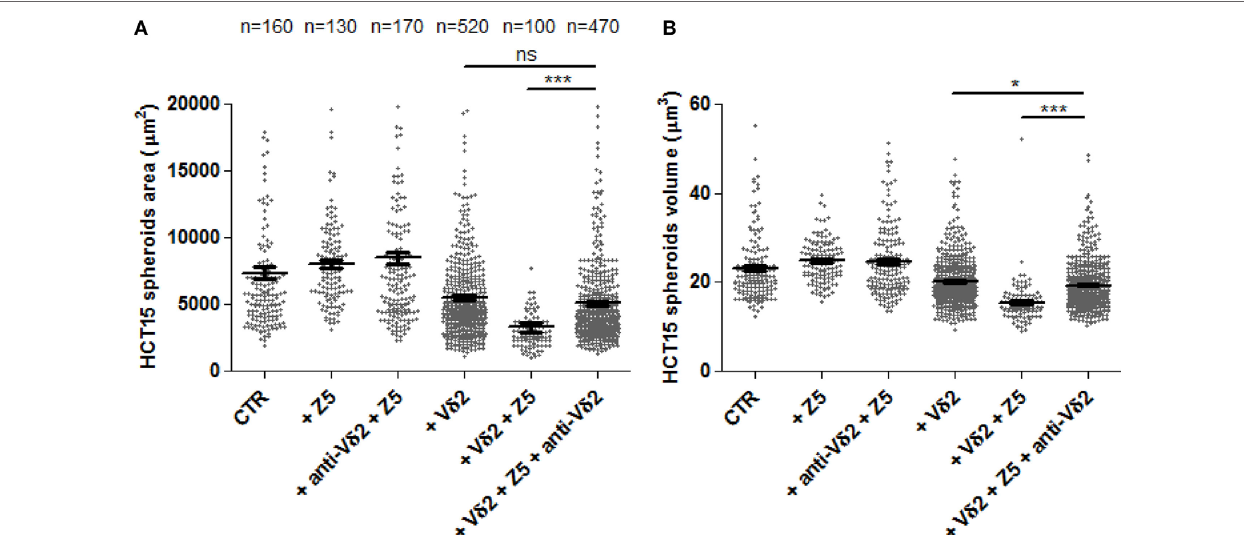
FIGURe 6 | The effects of Zol and V δ 2 T cells on CRC spheroids are dependent on V δ 2TCR. HCT15 spheroids were generated in serum free medium supplemented with epithelial growth factor (10 ng/ml) and incubated on day 6 for additional 24 h in medium without (CTR) or with 5 µM Zol ( + Z5) or V δ 2 T cells ( + V δ 2) or V δ 2 T cell populations + 5 μ M Zol ( + V δ 2 + Z5). In some experiments, saturating amounts of the anti-V δ 2-specific monoclonal antibody BB3 (5 µg/ml) were added at the onset of the 24 h incubation ( + anti-V δ 2 + Z5, + V δ 2 + Z5 + anti-V δ 2). Then, each culture well was analyzed for the identification and measurement of spheroids as area (A) or volume (B) . The number of spheroids analyzed is indicated in the upper part of panel (A) ; data are from experiments performed using six different V δ 2 T cell populations in triplicate wells for each donor. Each symbol in the plot indicates a single tumor cell spheroid. Bar: mean ± SEM of each group of measures. * p < 0.01; *** p < 0.0001; ns, not